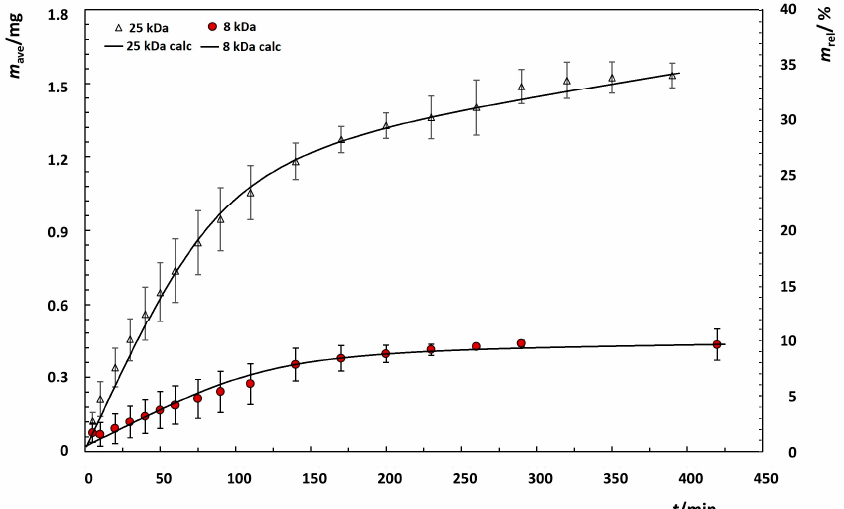
Figure 3. The cumulative mass of quercetin through dialysis membranes (8 kDa and 25 kDa) in PBS/EtOH (Vol.% 50:50) at a temperature of 37 ◦ C (observed and calculated, Equation (7)) (left ordinate) and the fraction of dialyzed quercetin relative to the total mass of loaded quercetin contained in the dialysis bag at t = 0 (right ordinate).